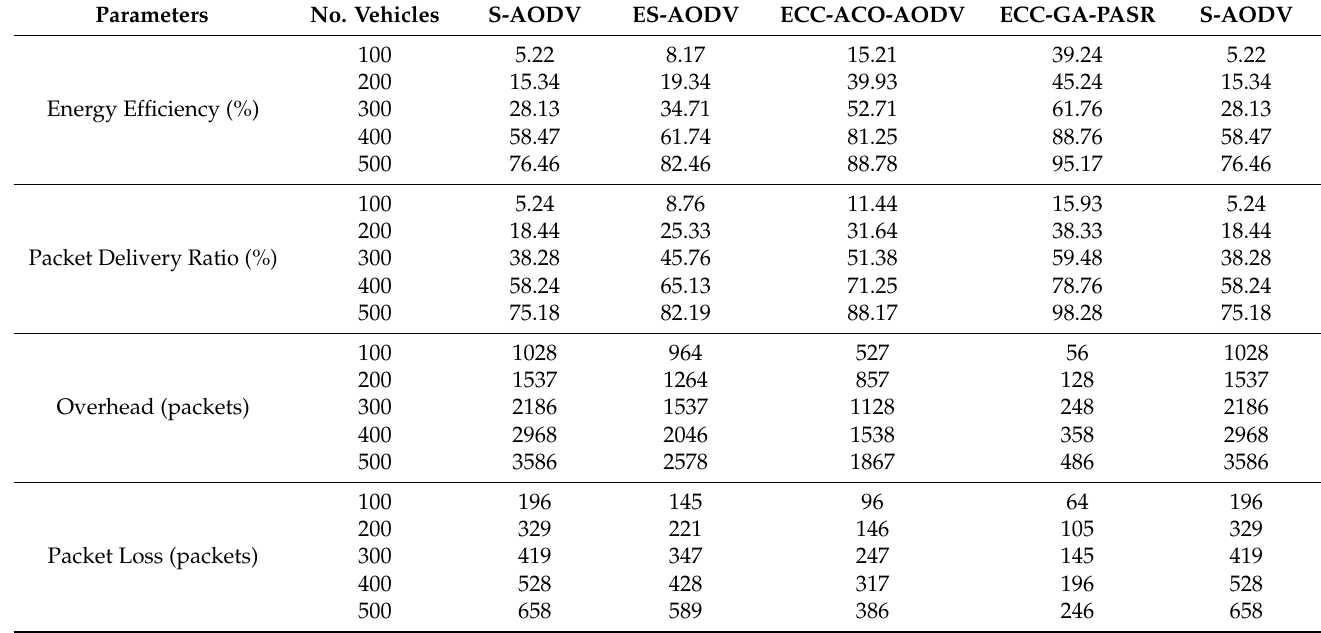
Table 7. Performance Analysis of Energy Efficiency, Packet Delivery Ratio, overhead, and Packet Loss concerning number of